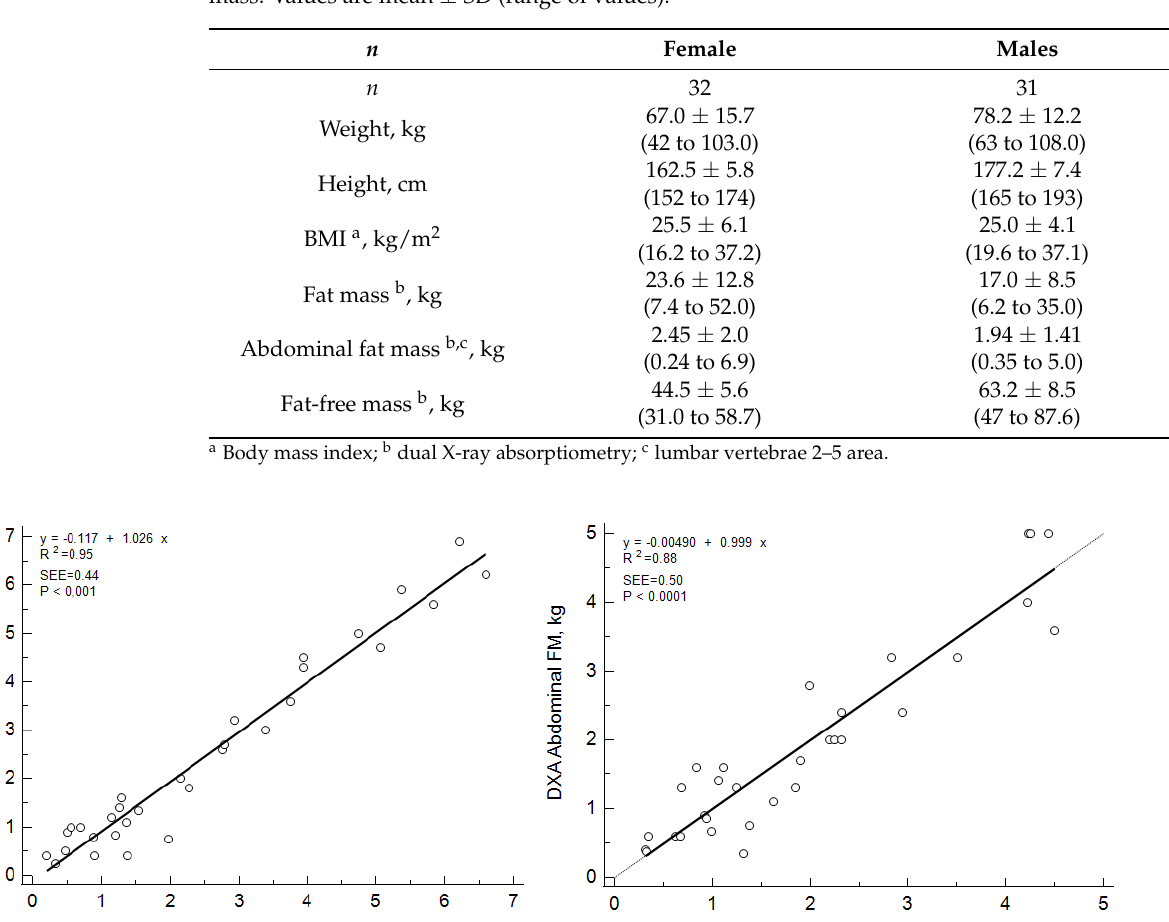
Table 2. Physical characteristics of adult participants in model development to predict abdominal fat mass. Values are mean ± SD (range of values).